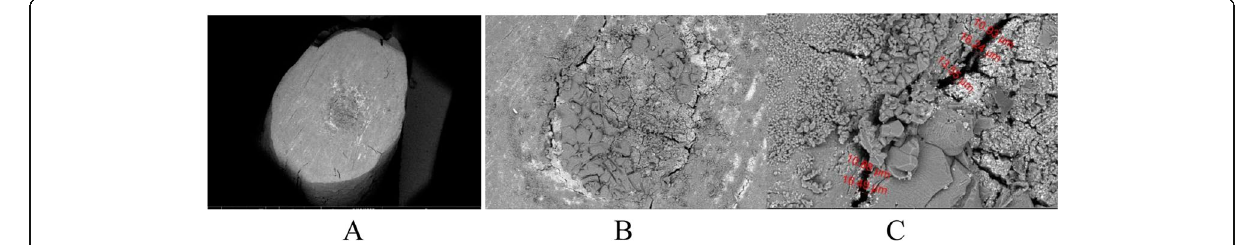
Fig. 4 SEM images of MTA Angelus. a × 50. b × 250. c ×